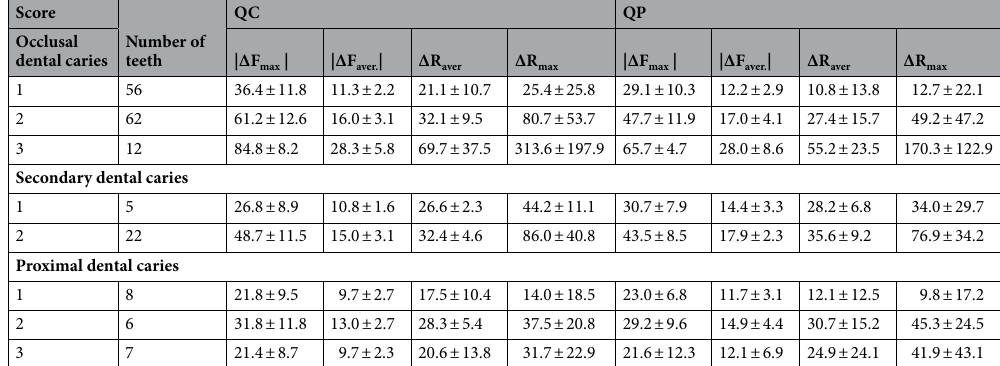
Table 1. Average and standard deviation of QLF parameters according to dental caries score. Quantitative light-induced fluorescence (QLF); Qraycam Pro® (QP); Qraypen C®